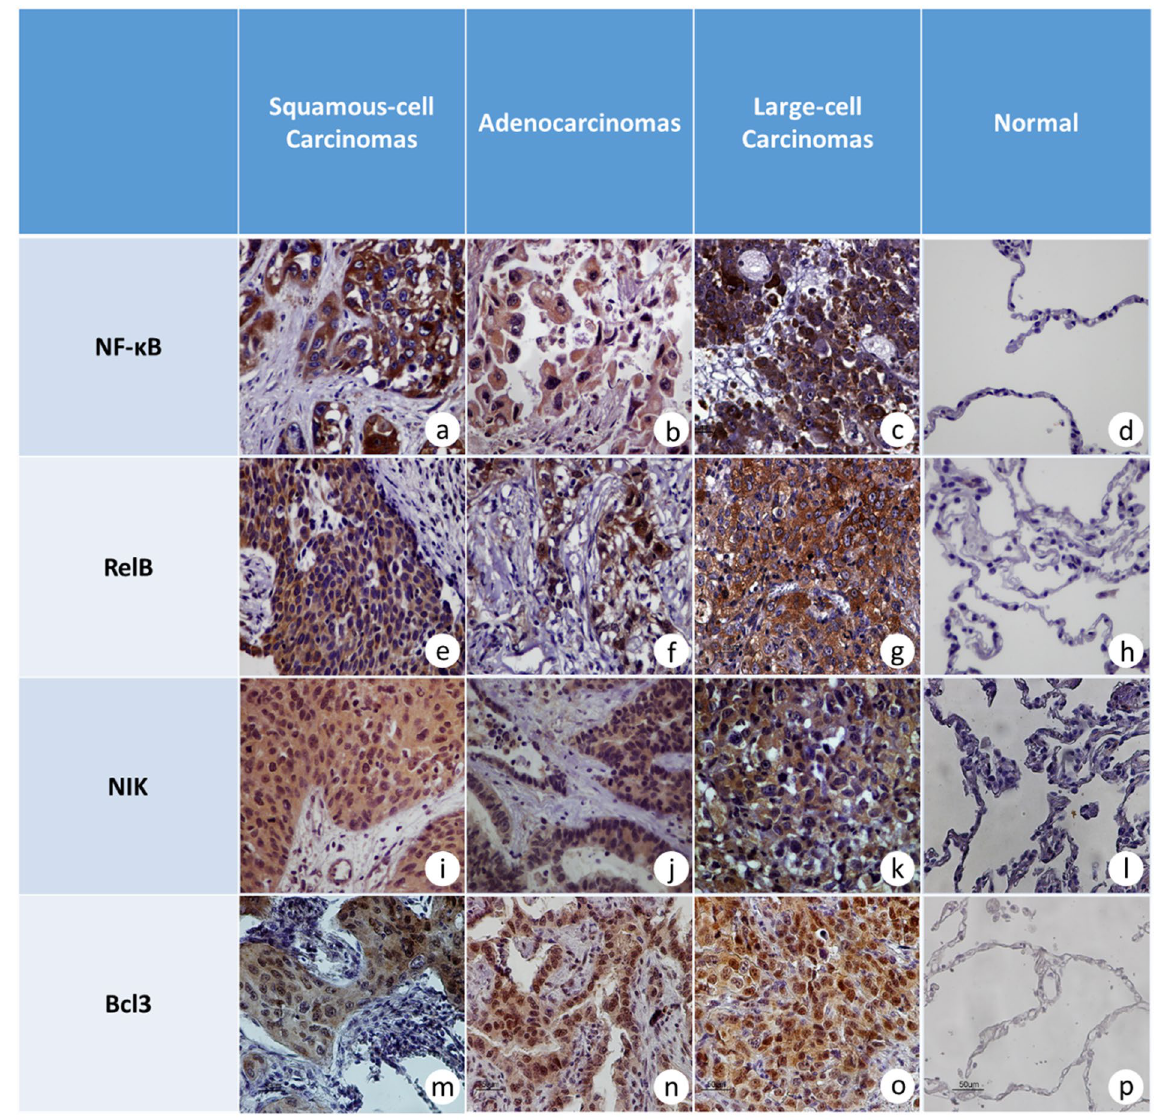
Figure 2. Microphotographs ( × 40) from tumor and tumor-adjacent, non-cancerous samples. ( a ) NF- κ B2 in a grade II, squamous lung carcinoma with strong and intermediate cytoplasmic staining without nuclear signal, ( b ) NF- κ B2 intermediate cytoplasmic staining in adenocarcinoma, ( c ) strong and intermediate cytoplasmic signal for NF- κ B2 in an undifferentiated large-cell carcinoma, ( d ) negative immunostaining for NF- κ B2 protein in alveolar epithelium and interstitium of tumor-adjacent non-neoplastic lung parenchyma, ( e ) RelB immunodetection in a grade III, squamous-cell carcinoma with strong cytoplasmic staining, ( f ) strong nuclear and cytoplasmic staining for RelB protein in grade III lung adenocarcinoma, ( g ) representative section of undifferentiated large-cell, lung carcinoma with strong cytoplasmic signal for RelB, ( h ) negative immunostaining for RelB in alveolar epithelium and interstitium of tumor-adjacent non-neoplastic lung parenchyma from a squamous-cell carcinoma, ( i ) representative section from a grade I, squamous -cell carcinoma with strong cytoplasmic staining for NIK, ( j ) intermediate cytoplasmic staining for NIK in an adenocarcinoma, ( k ) strong cytoplasmic immunostaining for NIK in large-cell lung carcinoma, ( l ) negative immunostaining for ΝΙΚ in alveolar epithelium and interstitium of adjacent non-neoplastic lung parenchyma from a large-cell carcinoma, ( m ) representative section of grade I, squamous-cell carcinoma with strong cytoplasmic and intermediate nuclear staining for Bcl3, ( n ) strong cytoplasmic staining for Bcl3 in a lung adenocarcinoma, ( o ) intermediate nuclear and strong cytoplasmic staining for Bcl3 protein in a large-cell lung carcinoma, ( p ) negative immunostaining for Bcl3 in alveolar epithelium of tumor-adjacent, non-neoplastic lung